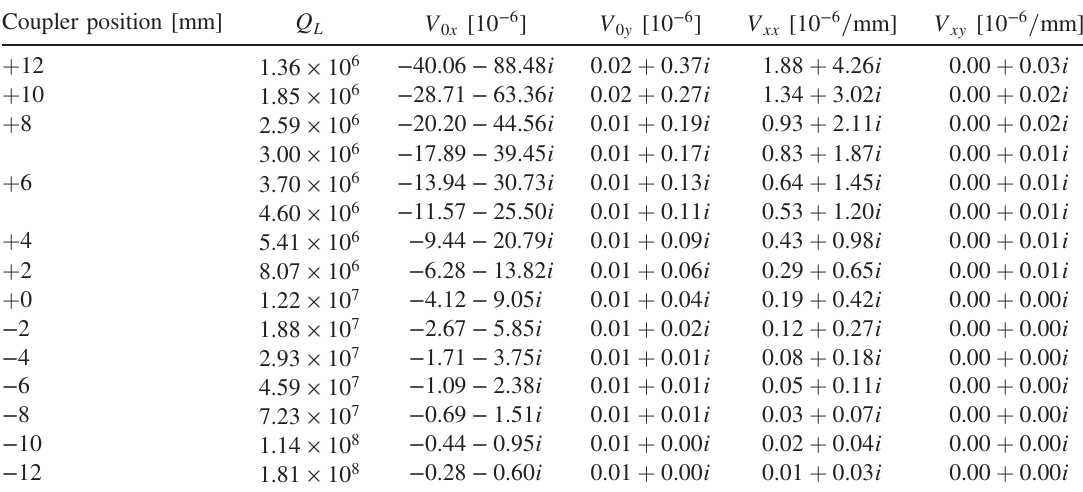
TABLE III. Coupler kick coefficients of the downstream coupler for the reflection dependent part, V Γ d [cf. Eq. (16)], as calculated with different field maps of the 1.3 GHz cavity for different values of the loaded quality factor Q L . The values for Q L ¼ 3 × 10 6 and Q L ¼ 4 × 10 6 reflect the standard Q L -setting for FLASH and European XFEL, respectively, and are evaluated using Eq. (18) and the fit parameters listed in Table V.